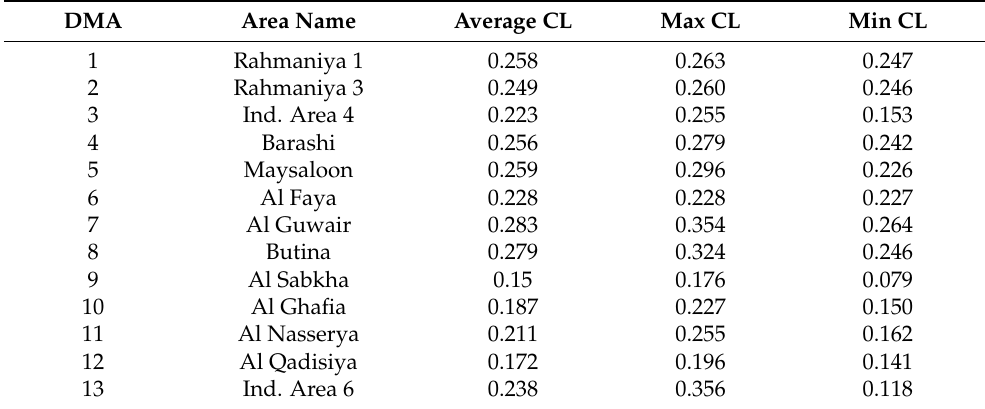
Table 2. Drops in chlorine (CL) in ppm.